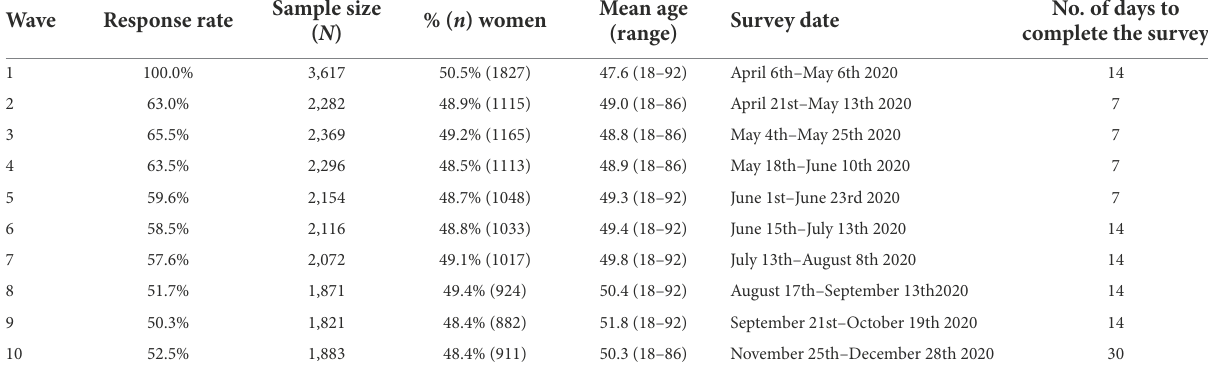
TABLE 1 Information about data collection.